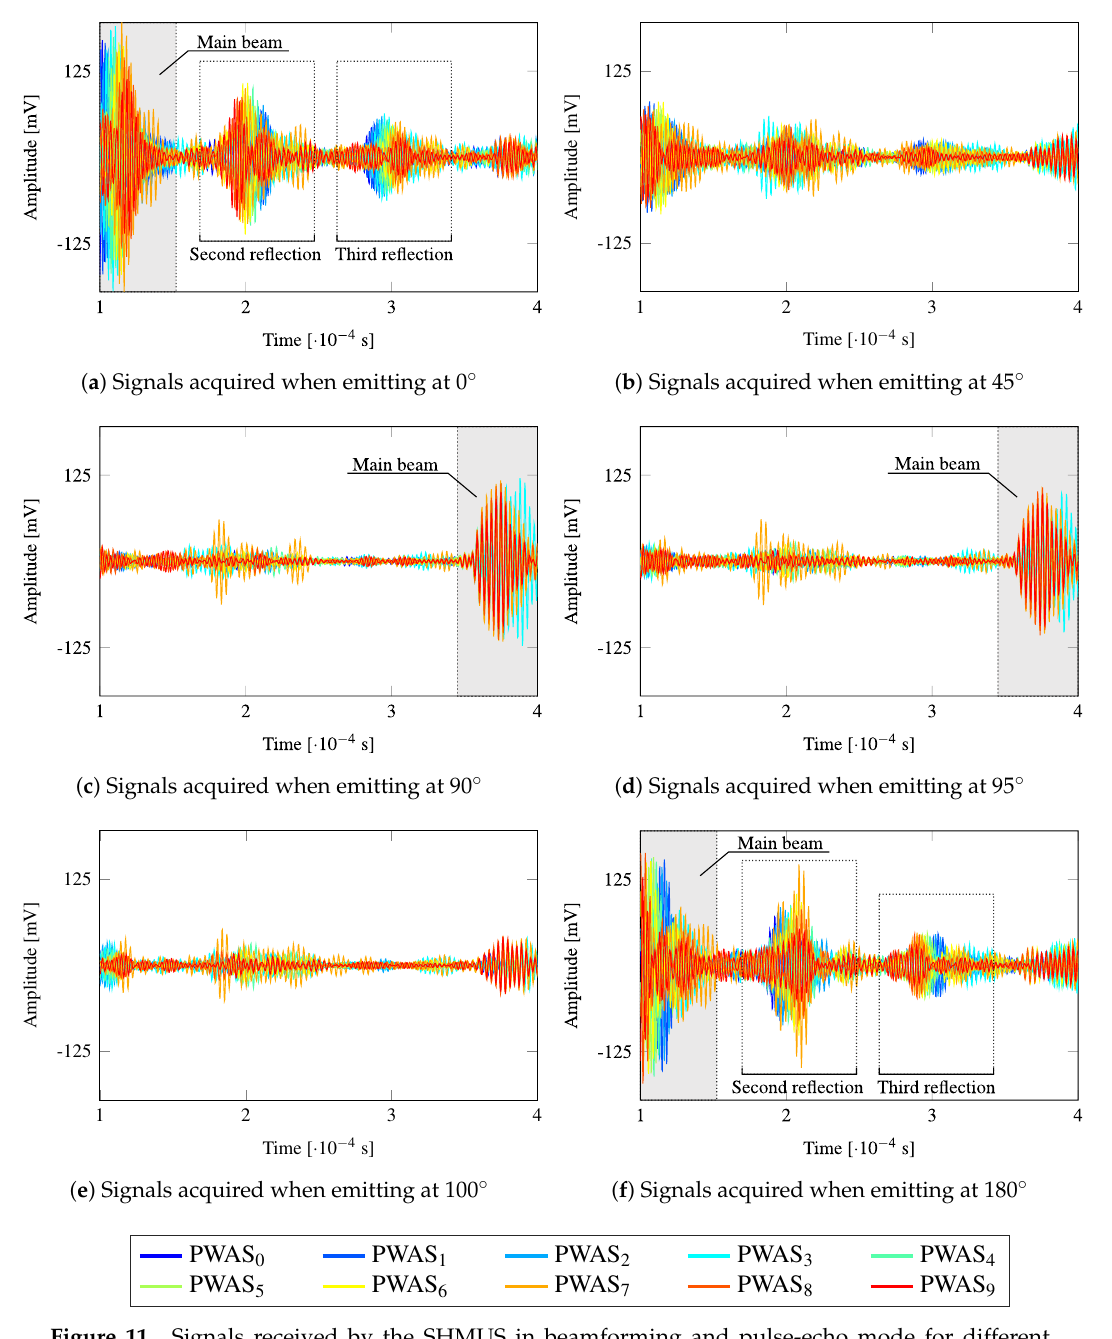
Figure 11. Signals received by the SHMUS in beamforming and pulse-echo mode for different steering